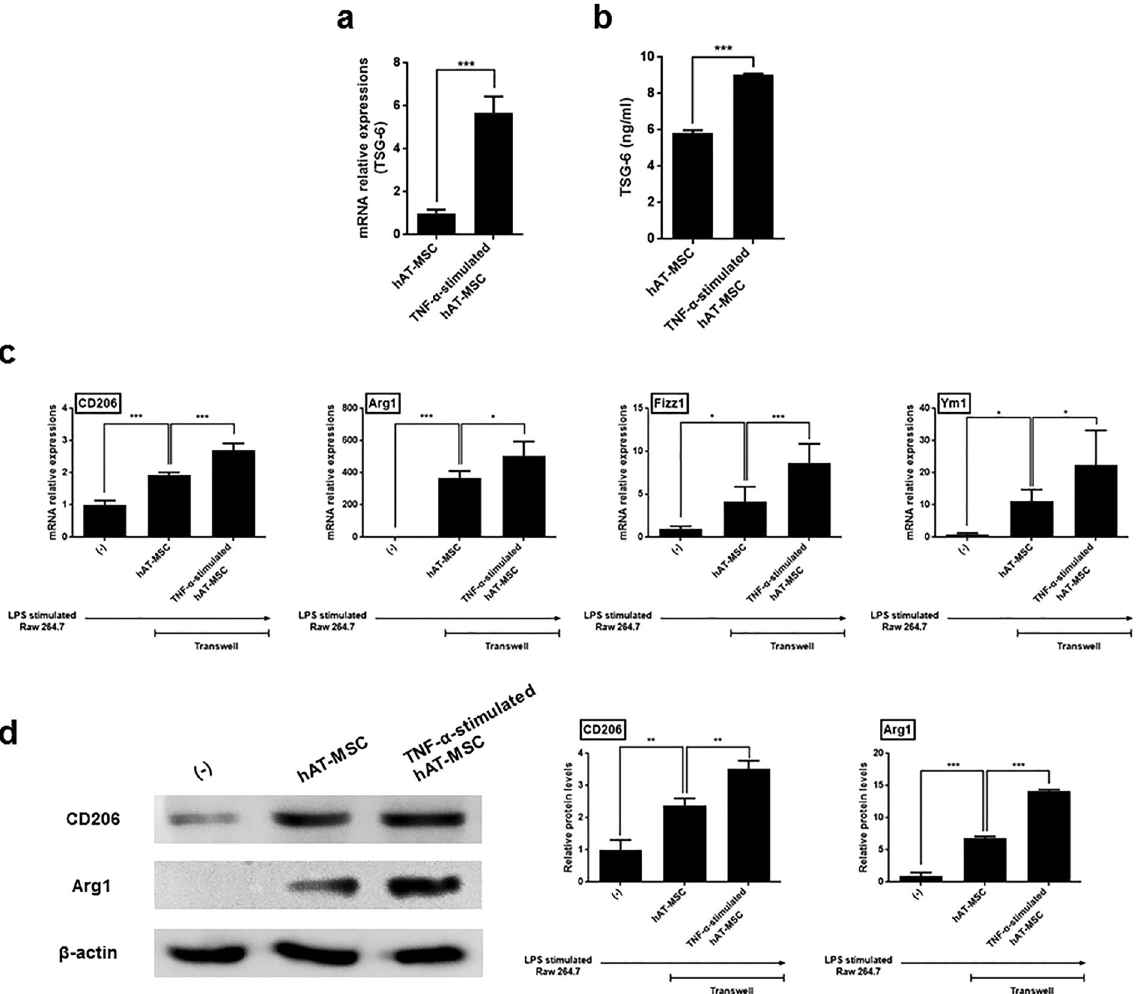
Figure 5. TNF- α -stimulated hAT-MSCs induce the expression of the M2 macrophage markers. ( a , b ) TSG-6 ( a ) gene and ( b ) protein expression levels in TNF- α -stimulated hAT-MSCs and naïve hAT-MSCs. ( c , d ) LPS- stimulated Raw 264.7 macrophages were co-cultured with naïve or TNF- α -stimulated hAT-MSCs in a transwell system for 48 h. ( c ) CD206, Arg1, Fizz1, and Ym1 mRNA expression levels. ( d ) CD206 and Arg1 protein expression levels in these cells. Results are presented as mean ± standard deviation of the data obtained in three independent experiments. * P < 0.05, *** P <